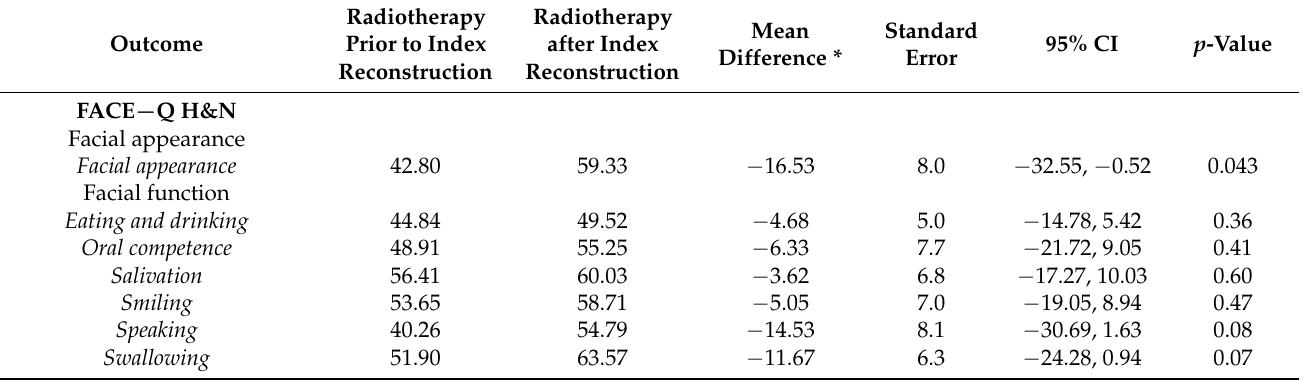
Table 4. Subgroup analysis examining the effect of timing of radiotherapy on health-related quality of life and functional outcomes measured using the FACE-Q H&N, MDADI and SHI (N = 62). Higher scores indicate better outcomes, except for the FACE-Q H&N Worry Scale and for the SHI Total Score, where higher scores indicate greater worry and greater levels of speech-related problems,